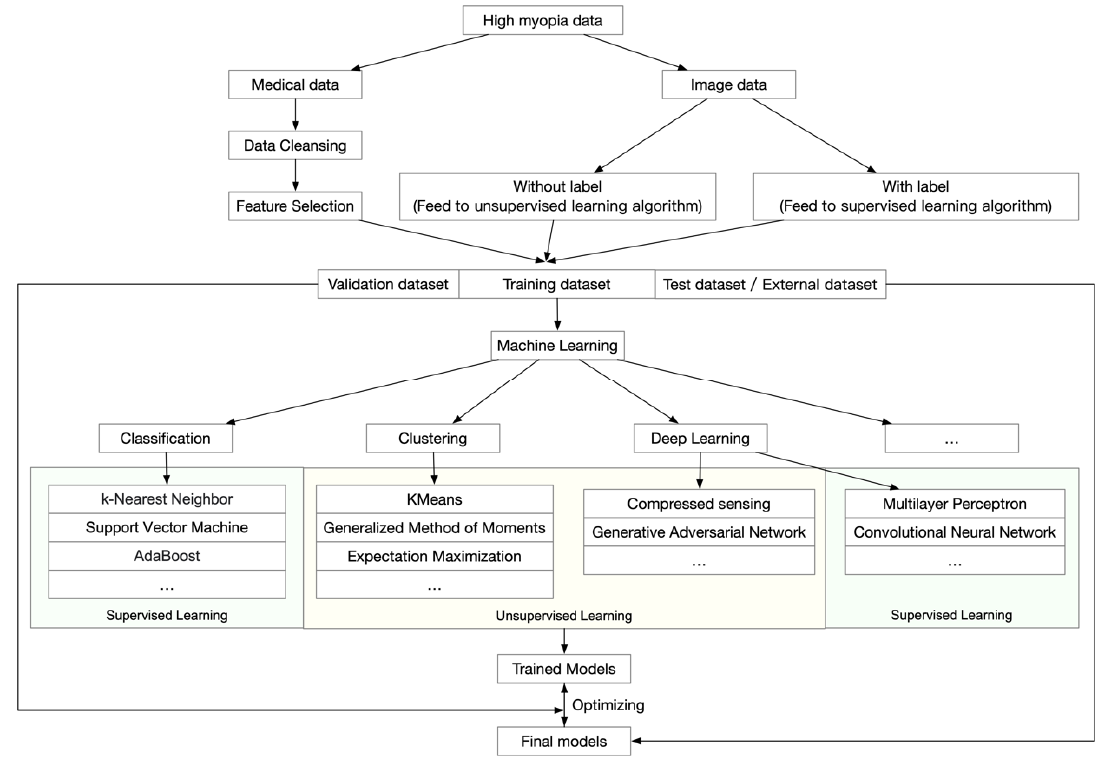
Figure 1. General workflow of artificial intelligence analyses of high myopia and pathologic myopia.